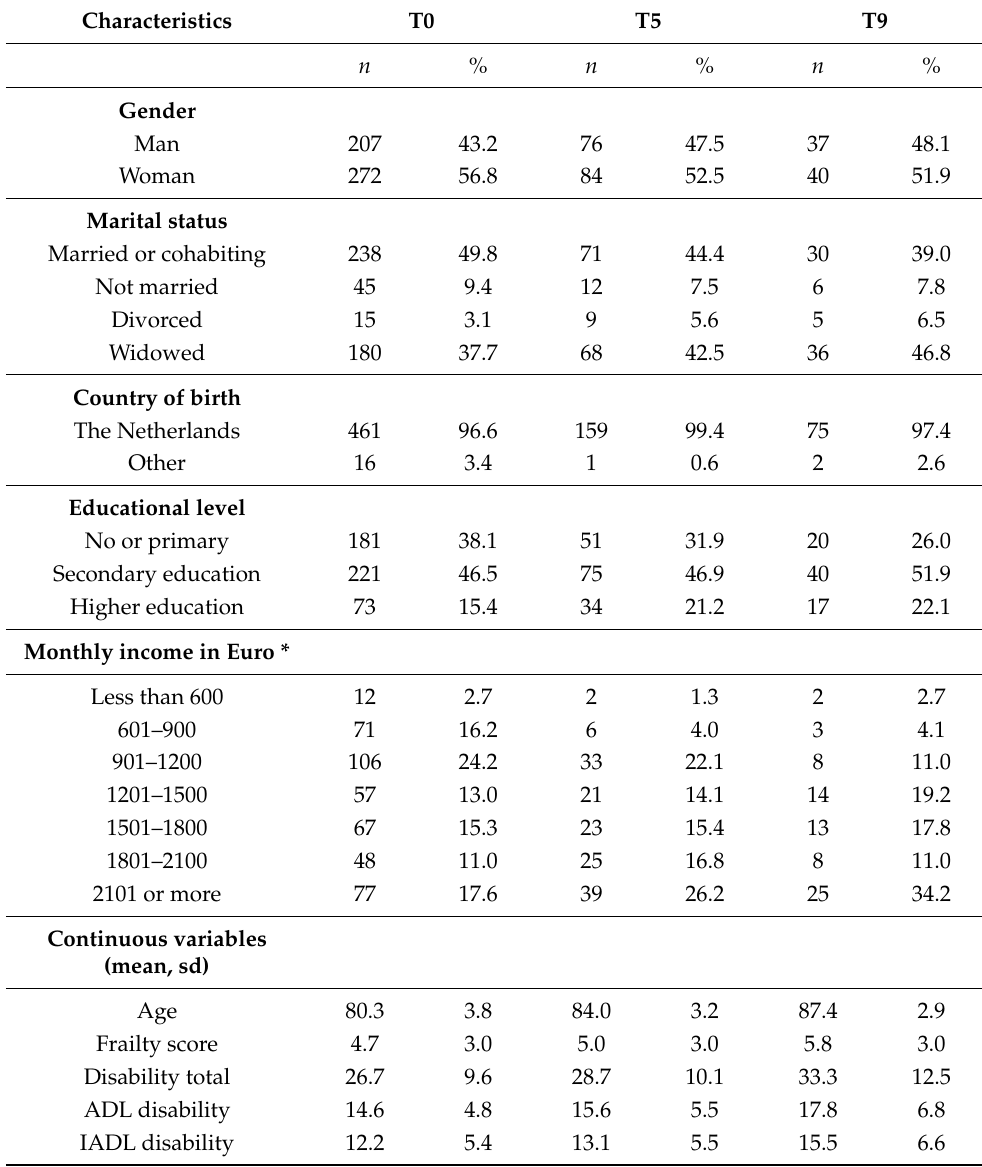
Table 1. Characteristics of the participants (T0, n = 479; T5, n = 160; T9, n = 77).